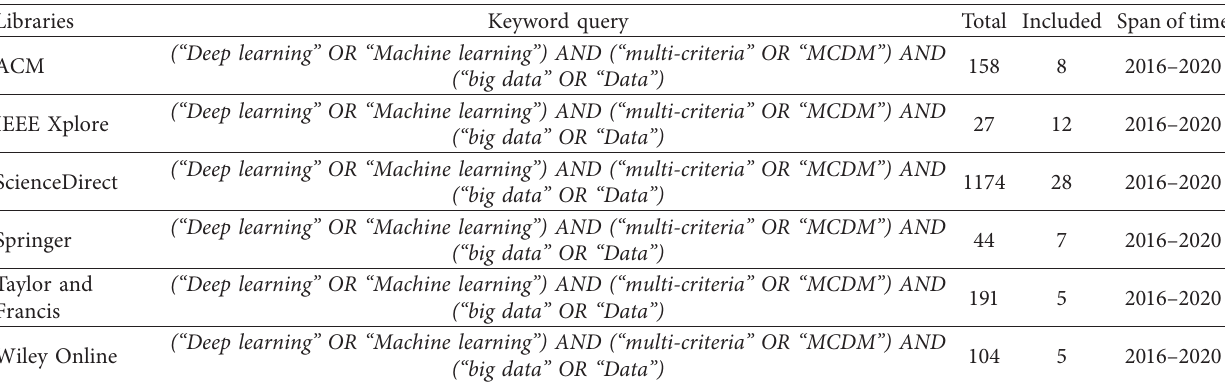
Figure 2: Search and filtering process of the proposed study. Table 1: Summary statistics of query execution in the given